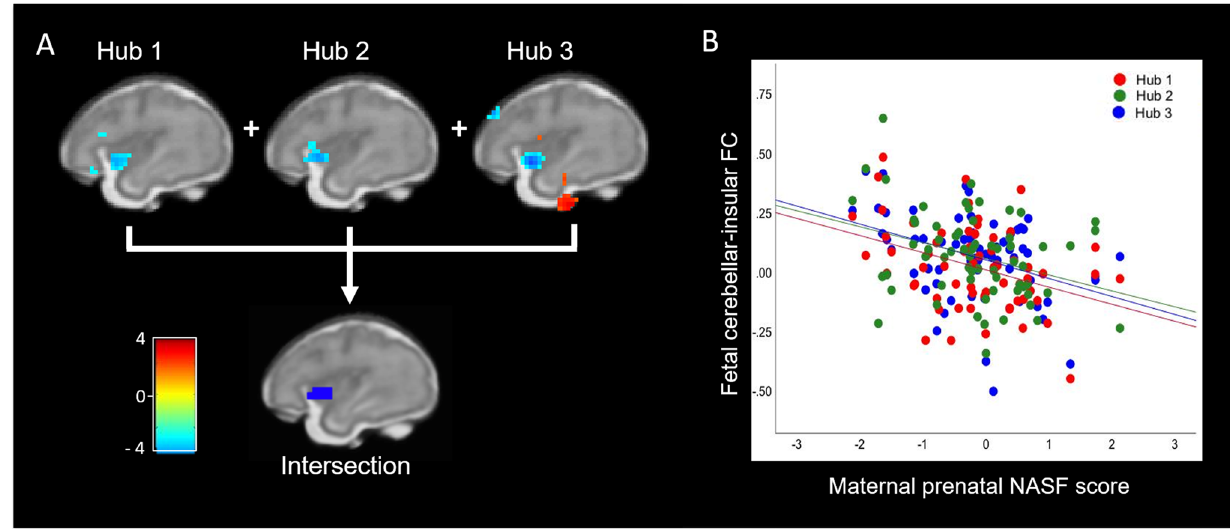
Figure 2. Cerebellar-insular connectivity in relation to maternal prenatal stress and negative affect. Cerebellar- insular connectivity (left insula) was related to maternal psychological stress during pregnancy, presented on a fetal template at 32 weeks of gestational age. ( A ) Shows the brain results of first three images. The top three images show the results for the individual cerebellar hubs (from left to right: Hubs 1, 2, 3; at k = 15, p < 0.01), while the lower image shows the combined effect of all three hubs (intersection), revealing a robust effect. ( B ) Shows a scatterplot of the results for the three hubs separately. Created using xjView for SPM 12 in Matlab R2019a. NASF Negative Affect and Stress Factor, FC Functional